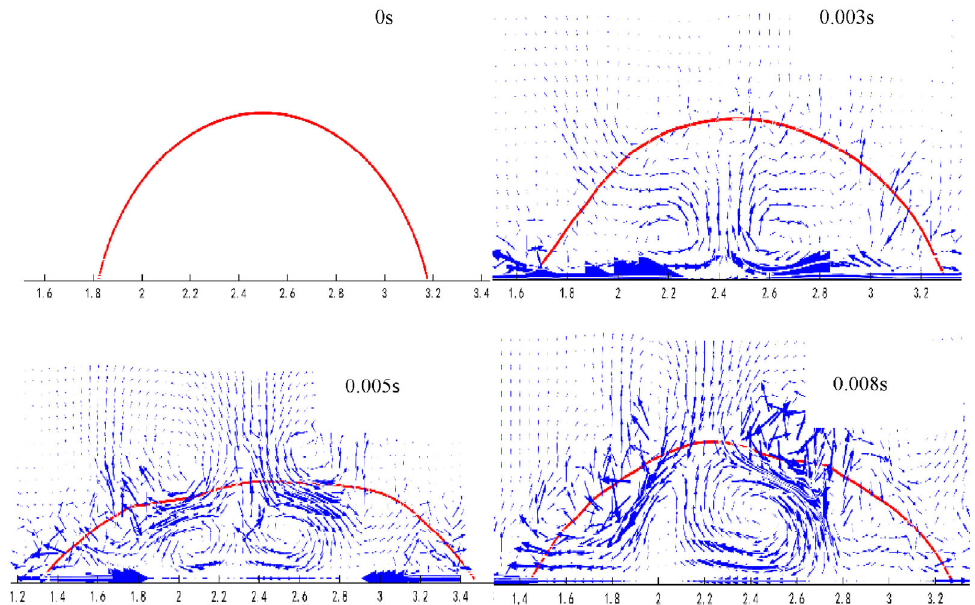
Fig. 13 Change of flow field of molten silicon droplet on graphite substrate ( θ = 45°) during motion